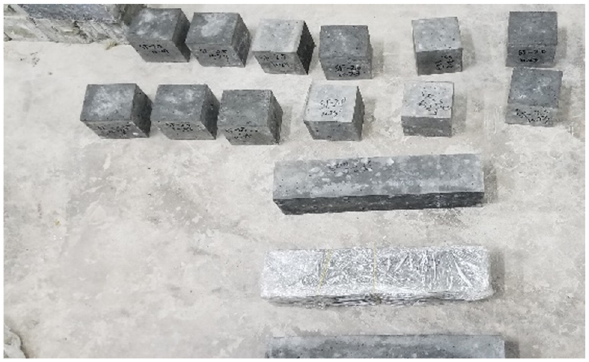
Figure 5: Concrete curing.